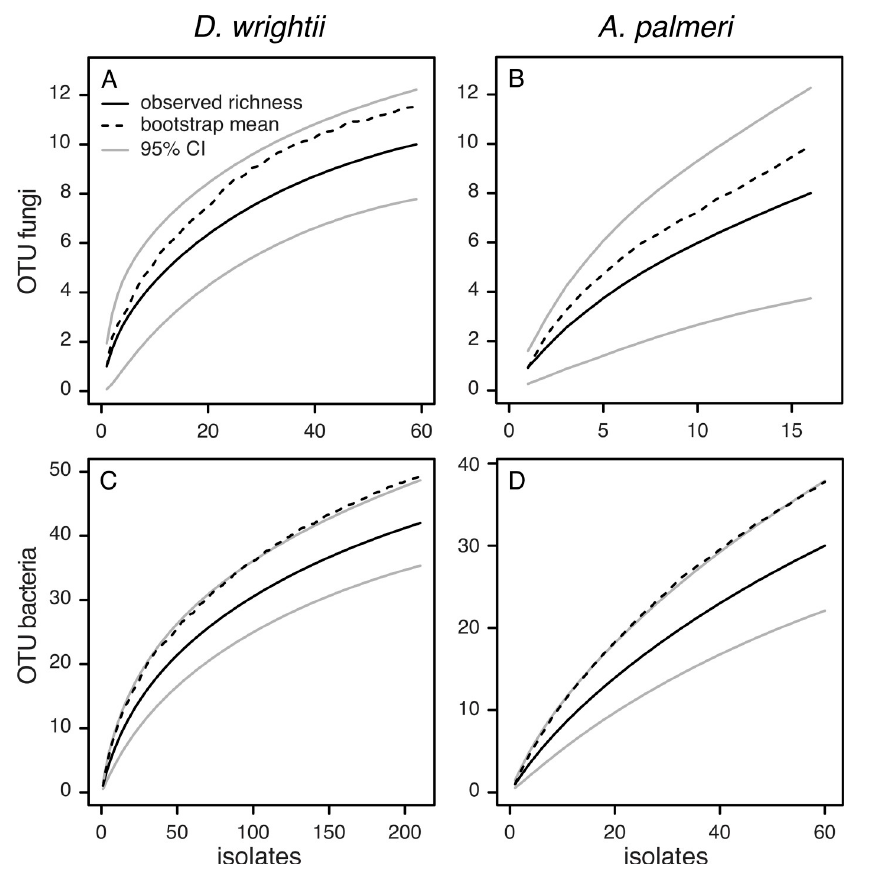
Fig 5. Richness of nectar microbes in D . wrightii and A . palmeri flowers. (A) Species accumulation curve for fungi in D . wrightii nectar samples (N = 59 isolates). (B) Species accumulation curve for fungi in A . palmeri nectar samples (N = 16 isolates). (C) Species accumulation curve for bacteria in D . wrightii nectar samples (N = 210 isolates). (D) Species accumulation curve for bacteria in A . palmeri nectar samples (N = 60 isolates). Figures show the number of fungi and bacteria species observed (here estimated as OTU) (Mao Tau; black lines), lower and upper 95% confidence intervals (light gray lines), and bootstrap estimate of richness (dashed